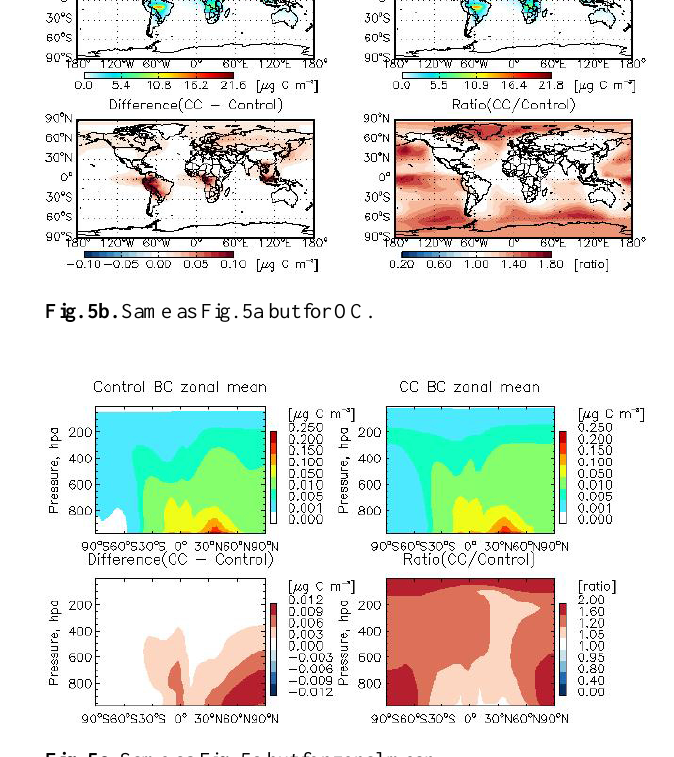
Fig. 5c. Same as Fig. 5a but for zonal